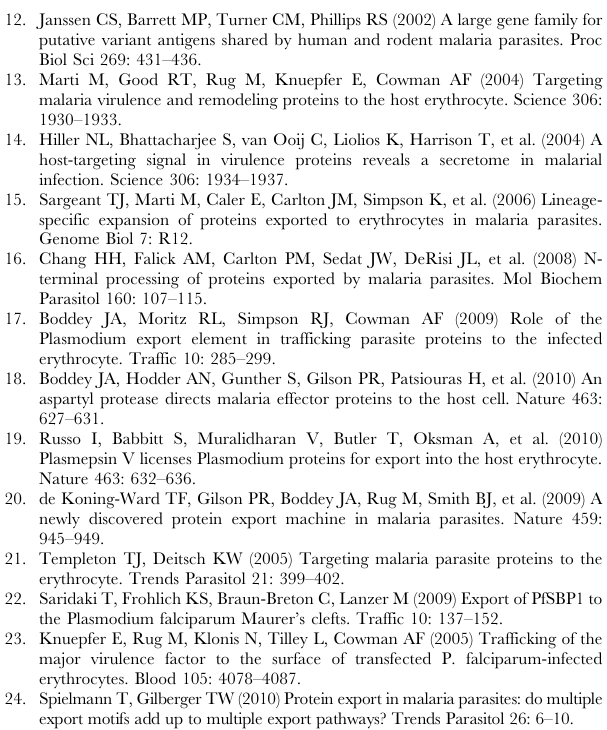
Table S1 Primers used in the